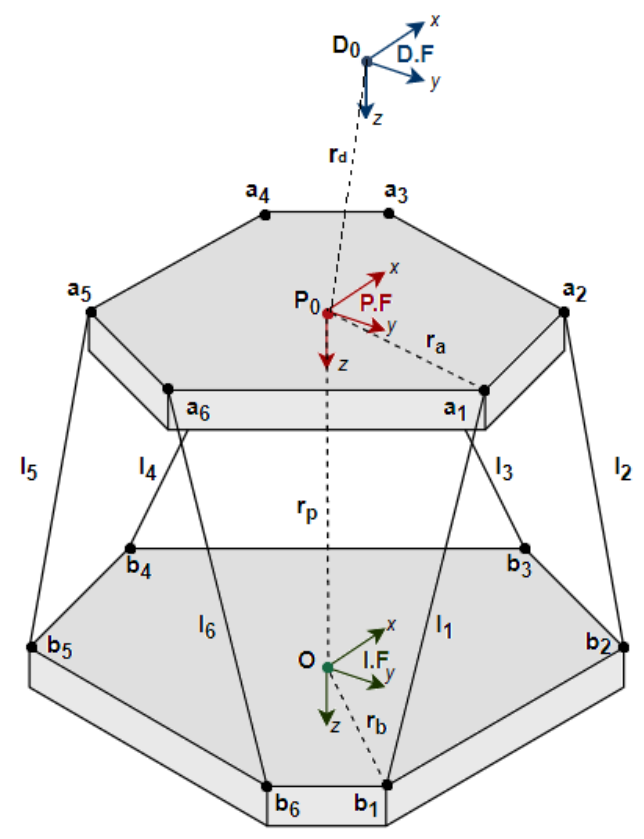
Figure 4. Motion Platform and reference frames used in the